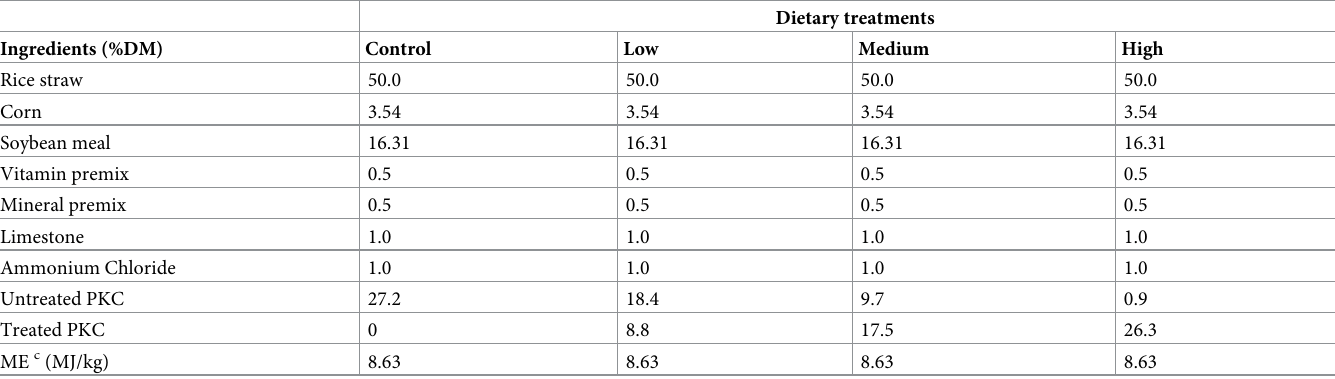
Table 1. Composition of diets (% in total mixed ration).